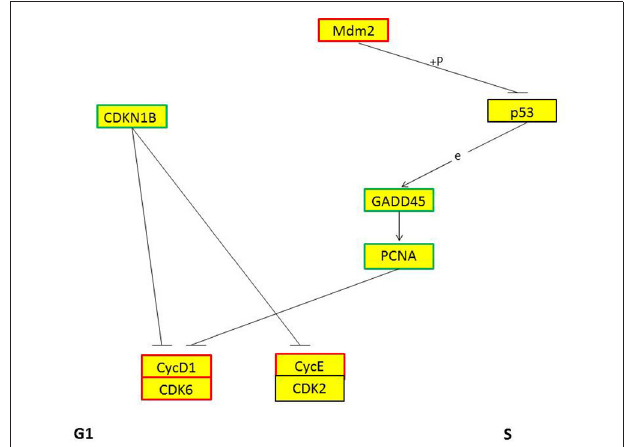
FIGURE 13 | KEGG pathway of genes regulating cell period from G 1 phase to S phase. Red frame means this gene is up-regulated, blue frame means this gene is down-regulated, + p means phosphorylation, e means expression.